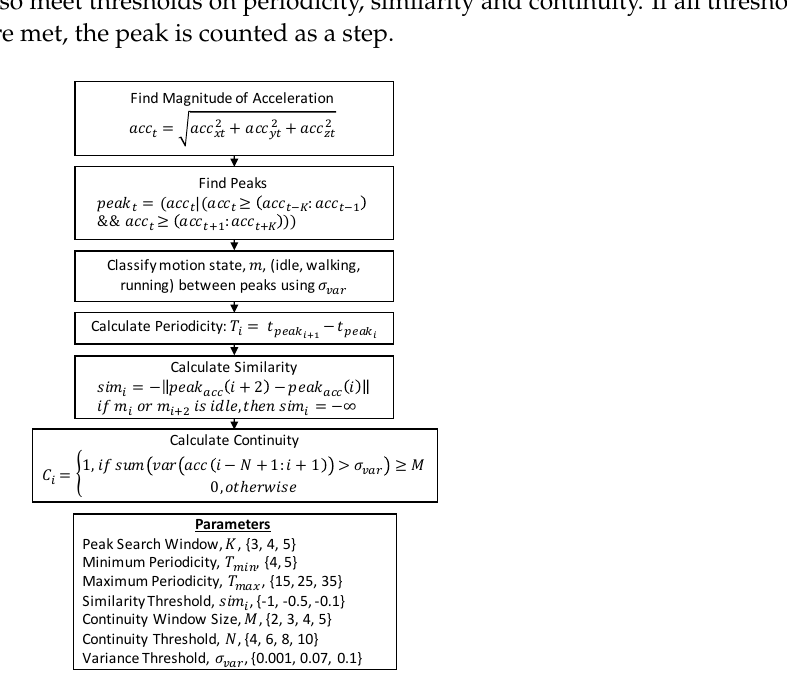
Figure 5. Flow chart describing the implementation of the peak detector